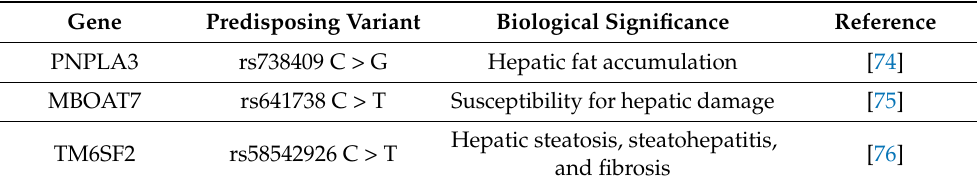
Table 1. Genetics mechanisms involved in NAFLD pathogenesis and IR. Gene Predisposing Variant Biological Significance Reference